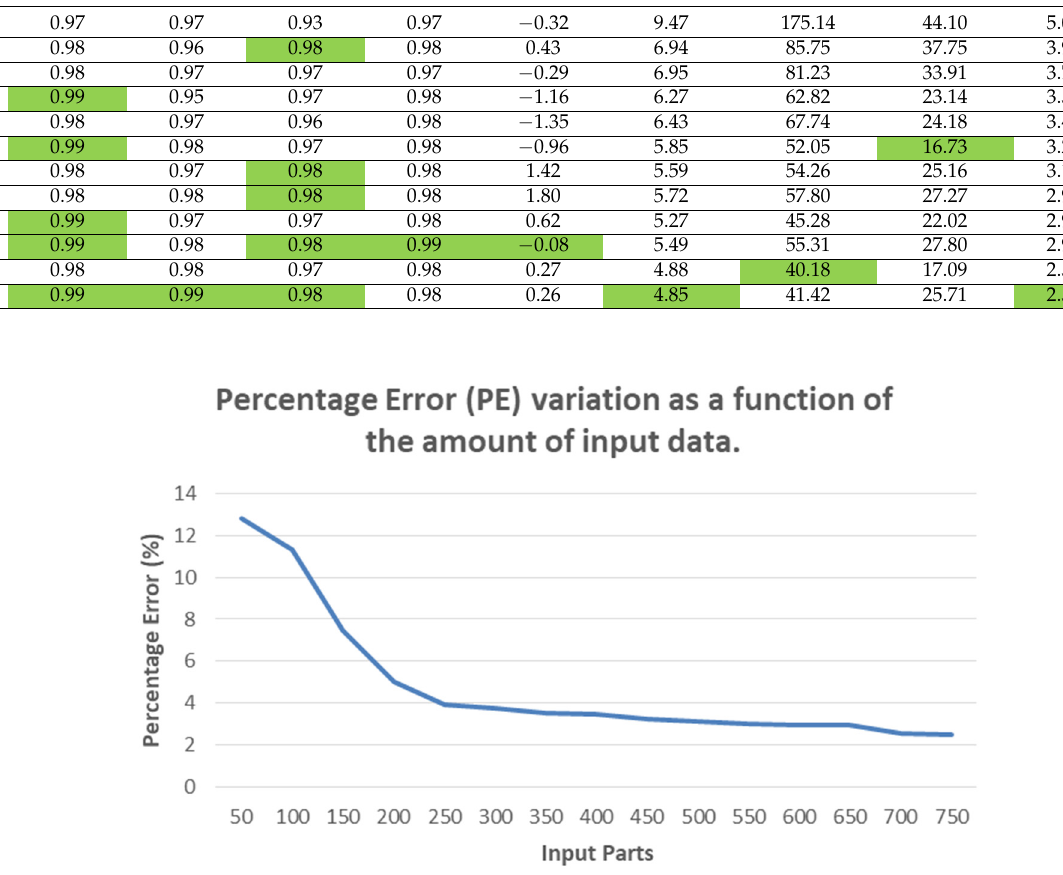
Table 5. Regression and error of the ANNs from Test 3.